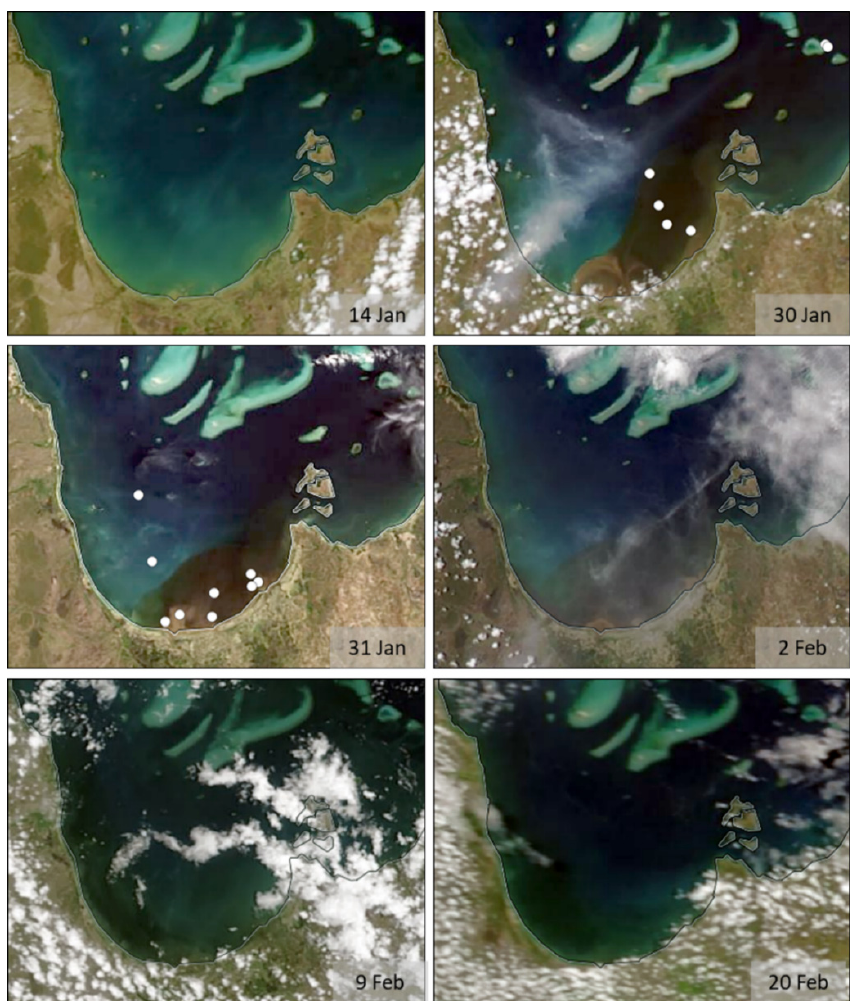
Figure 4. Time series of MODIS-Aqua and -Terra RGB imagery on 14, 30, 31 January and 2, 9 and 20 February 2013. The sampled stations are shown for 30 and 31 January. Image credit: NASA EOSDIS Worldview.